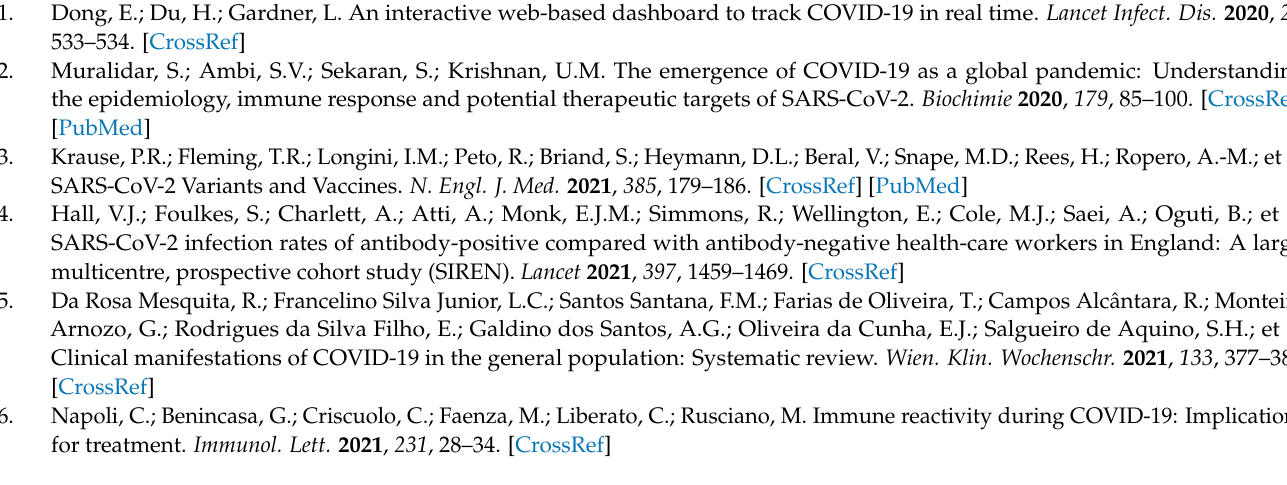
Table S2: CD3+ Multi-Pathway Signaling; Table S3: CD19+ Multi-Pathway Signaling; Table S4: CD11b+ Multi-Pathway Signaling; Table S5: Percentages of B cell Subpopulations; Table S6: Serum Anti- bodies; Table S7: Percentages of Monocyte Subpopulations; Table S8: Percentages of Granulocyte Subpopulations; Table S9: Percentages of CD8+ T Cell Subpopulations; Table S10: Expression of CD38 among CD8+ T Cell Subpopulations; Table S11: Percantages of CD4+ T Cell Subpopulations; Table S12: Percantages of NK Cell Subpopulations; Table S13: Serum Cytokines; Table S14: Absolute Numbers of Live Leukocytes; Table S15: Apoptotic among Live Leukocytes; Table S16: Correlations among Humoral and Cellular Immune Parameters in Healthy Controls; Table S17: Correlations among Humoral and Cellular Immune Parameters in COVID-19